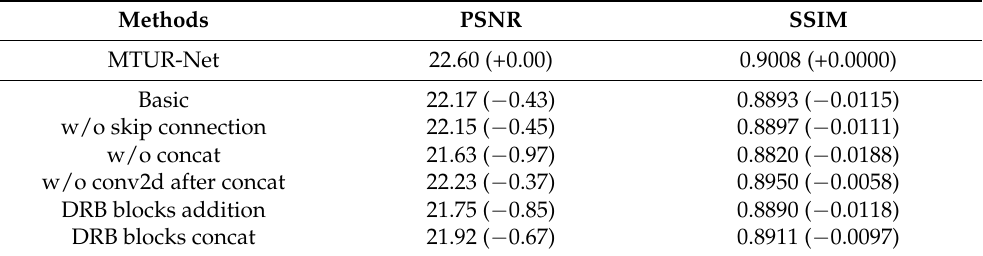
Table 4. Component Analysis. The Basic Model is MTUR-Net without the MT-Guided Non- Local